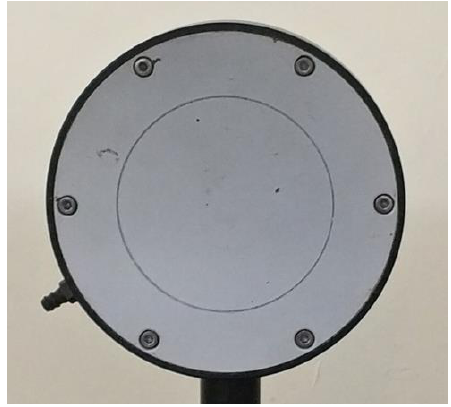
Figure 5. Object capable of rotating in-plane by a micro-head.